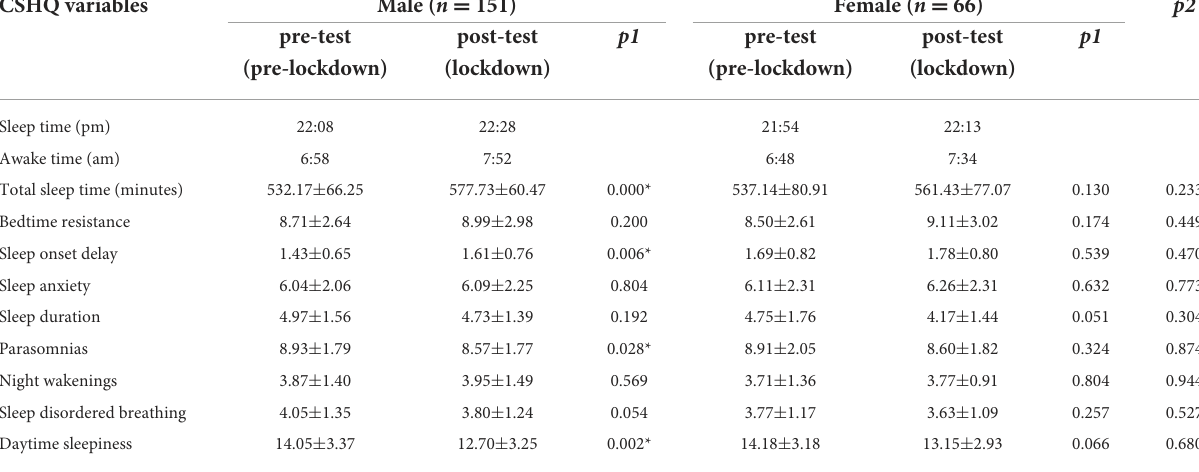
TABLE 1B Comparison of CSHQ of different genders during the lockdown and pre-lockdown periods. CSHQ